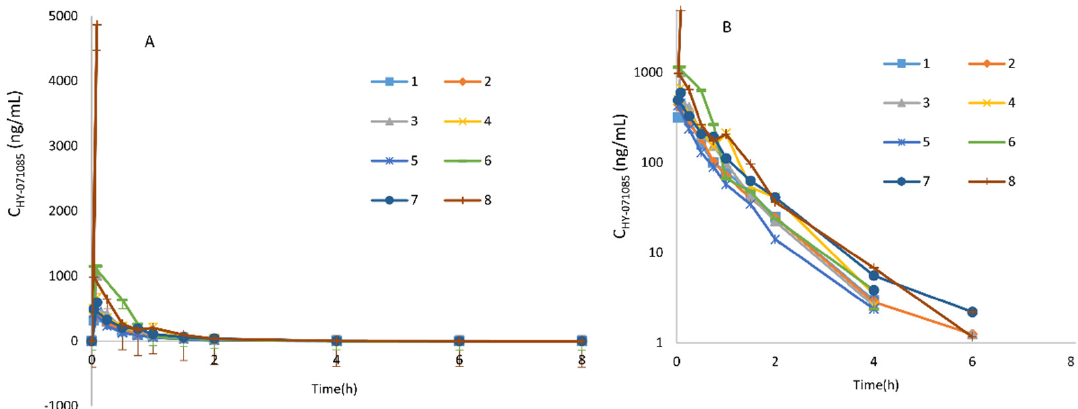
Figure 8. Comparison of the mean plasma concentration–time curves of HY-071085 after the single- dose intragastric administration of HY-071085 at low (1.25 mg/kg), medium (2.5 mg/kg) and high (5 mg/kg) doses in beagle dogs. ( A , B ): Constant coordinates; ( C , D ): semilogarithmic coordinates.